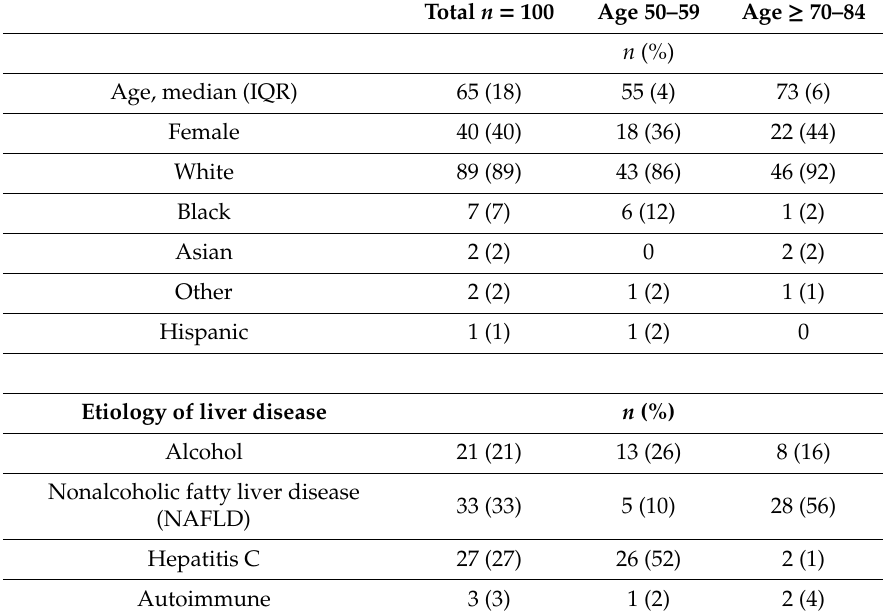
Table 1. Description of study